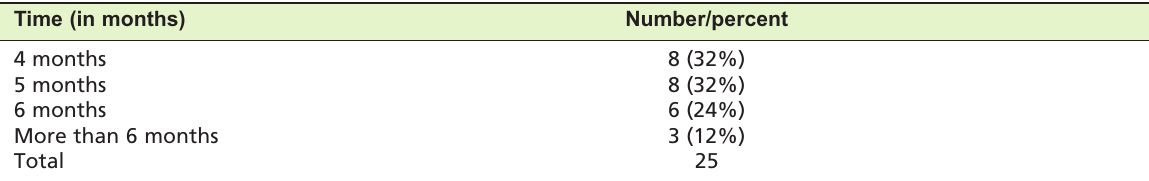
Bone union time Table I: